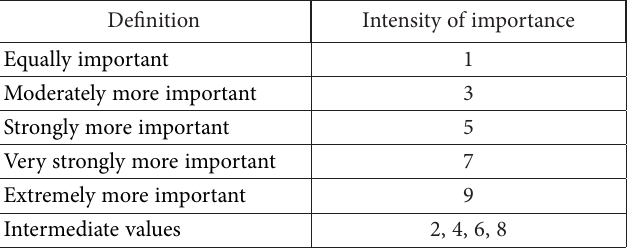
Table 2. Nine-point intensity of importance scale and its